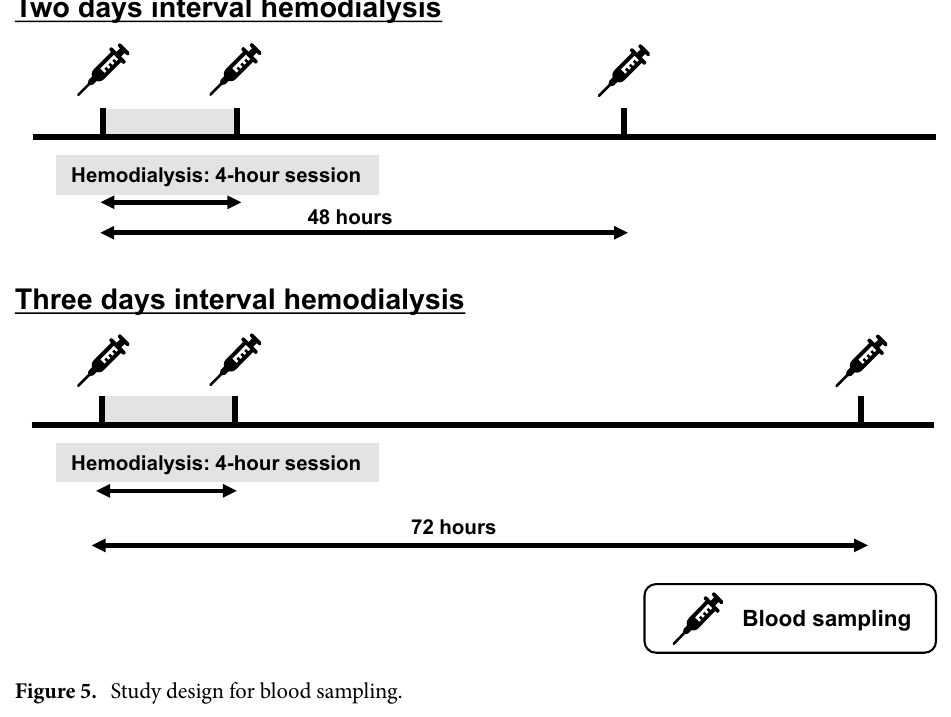
Figure 5. Study design for blood